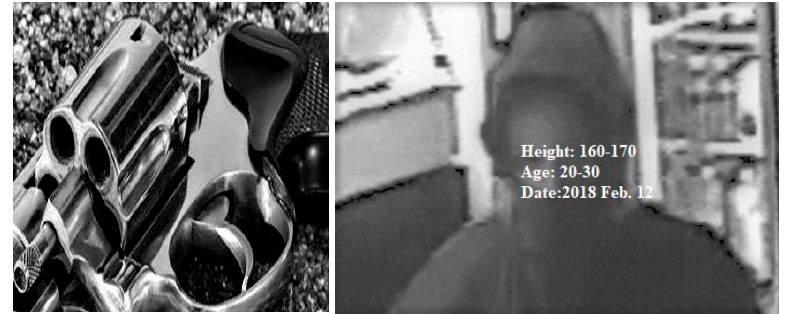
Figure 6. An image for crime investigation.